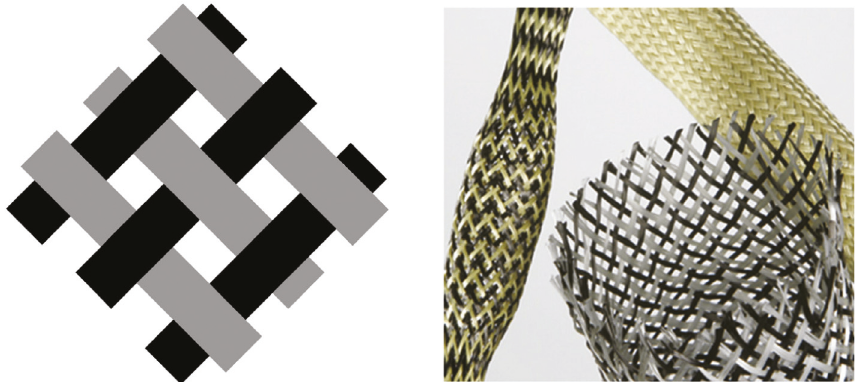
Figure 6: Schematics for braided structures